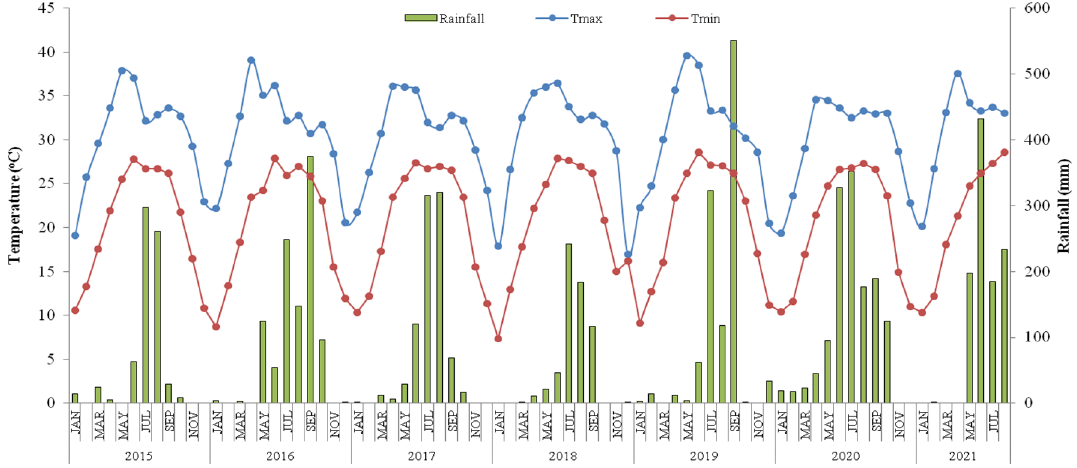
Figure 1. Monthly total rainfall and mean monthly maximum and minimum temperatures prevailed during the experimental period (January 2015 to July